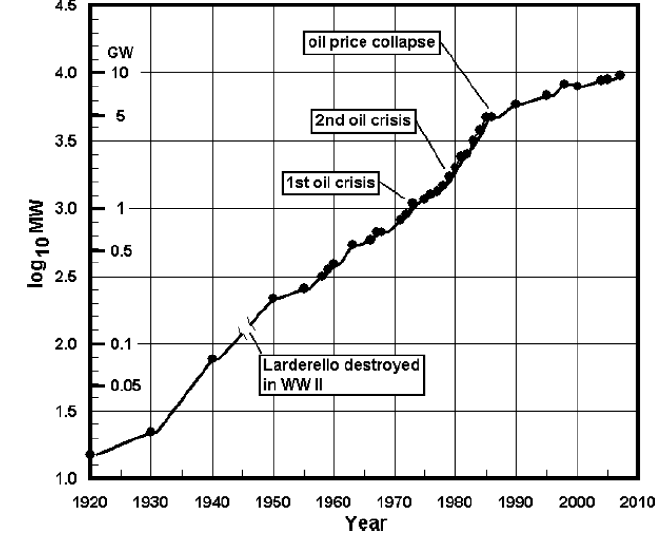
Figure 72. Development of worldwide installed geothermal capacity. © 2008 Elsevier, reproduced with permission from [301].